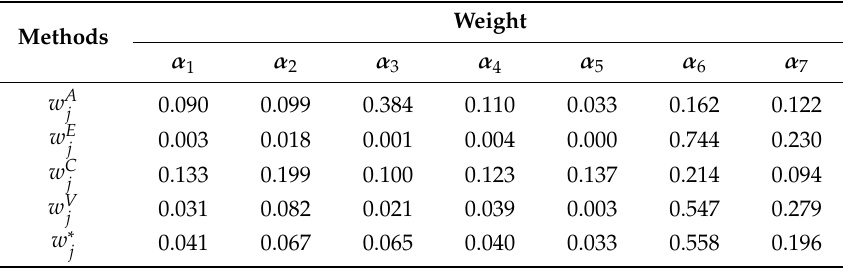
Table 4. Indexes’ weights determined by di ff erent methods.